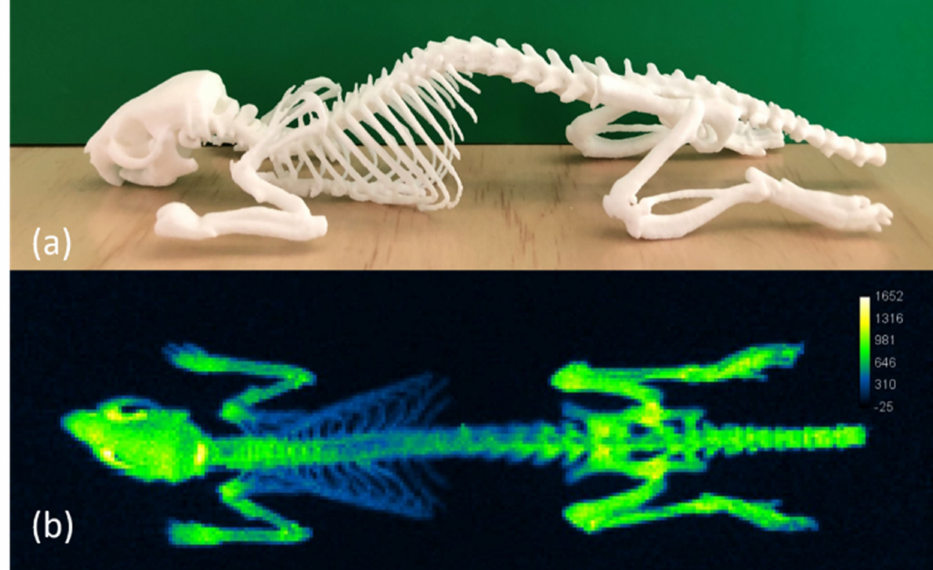
Figure 3. Three − dimensional (3D) printed PA2200 anatomical phantom of rat skeleton. ( a ) Photograph of a white PA2200 3D printed phantom. ( b ) PL image of phantom taken with open emission after preliminary charge with ambient